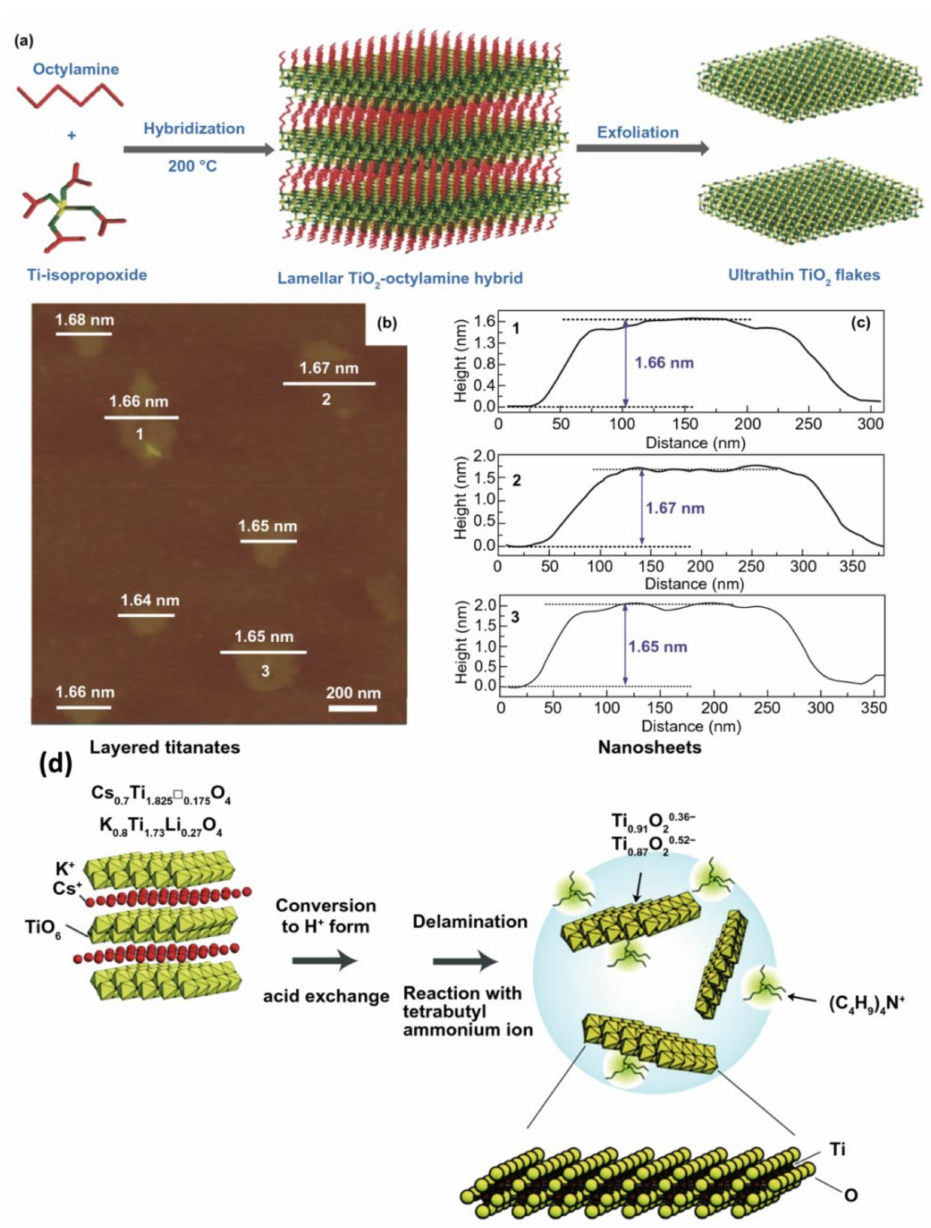
Figure 1. Flakes of ultrathin TiO 2 : ( a ) Synthesis scheme, adapted from [2] Copyright 2016 Elsevier B.V.; ( b ) AFM image; ( c ) AFM images of height profiles in ( b ), adapted from [1] Copyright 2018, John Wiley & Sons; ( d ) exfoliation of titanate crystals of the lepidocrocite type into TiO 2 nanostructures is depicted schematically, adapted from [5] Copyright 2016, The Royal Society of